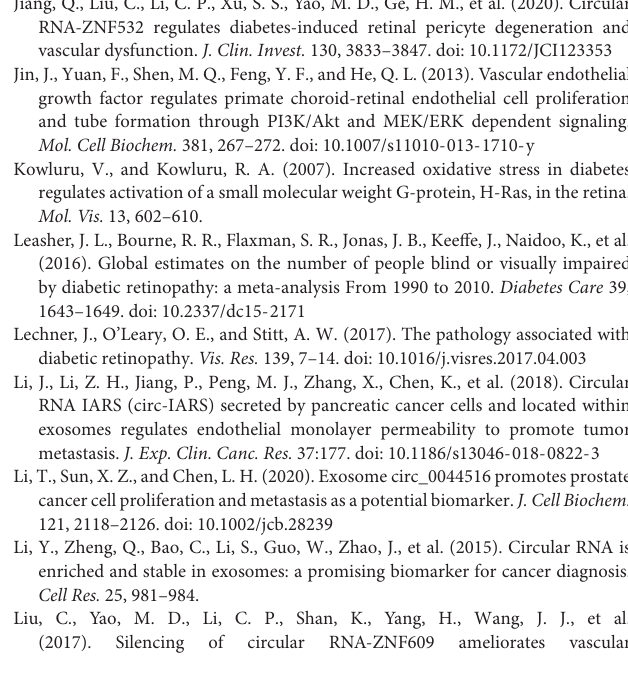
Supplementary Figure 1 | The scatter plot and hierarchical clustering analysis showed the expression of circRNAs between the two groups in serum exosomes. Supplementary Figure 2 | The scatter plot and hierarchical clustering analysis showed the expression of miRNAs between the two groups in serum exosomes. Supplementary Figure 3 | The scatter plot and hierarchical clustering analysis showed the expression of mRNAs between the two groups in serum